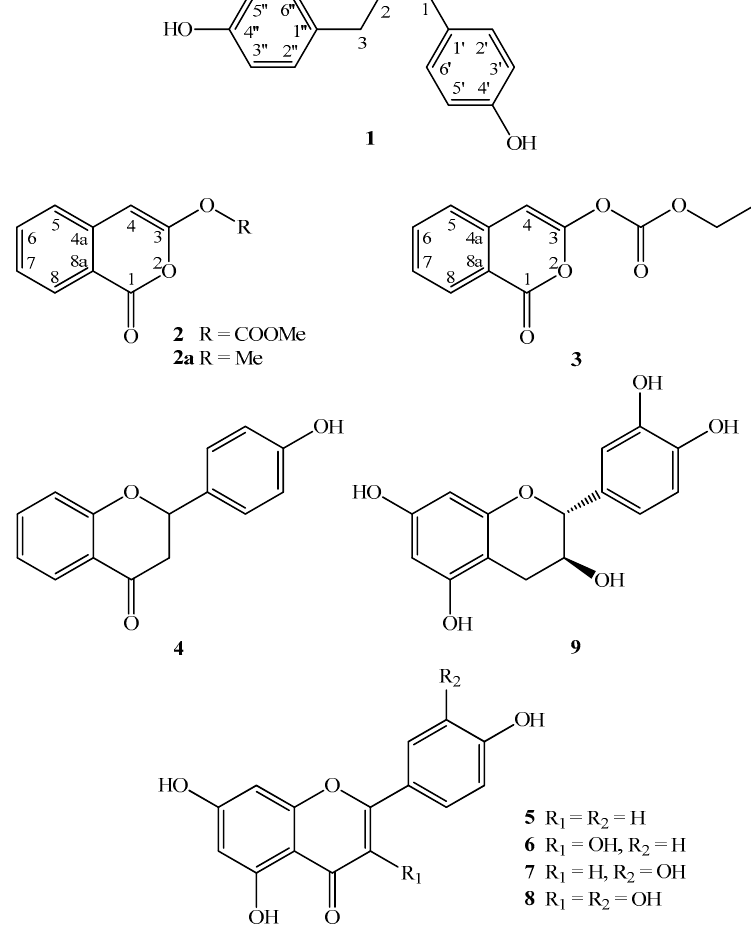
Figure 1. The chemical structures of compounds 1 – 9 .